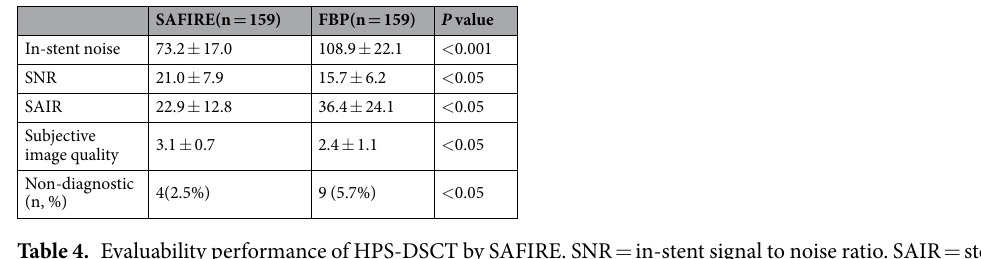
Table 4. Evaluability performance of HPS-DSCT by SAFIRE. SNR = in-stent signal to noise ratio. SAIR = stent lumen attenuation increase